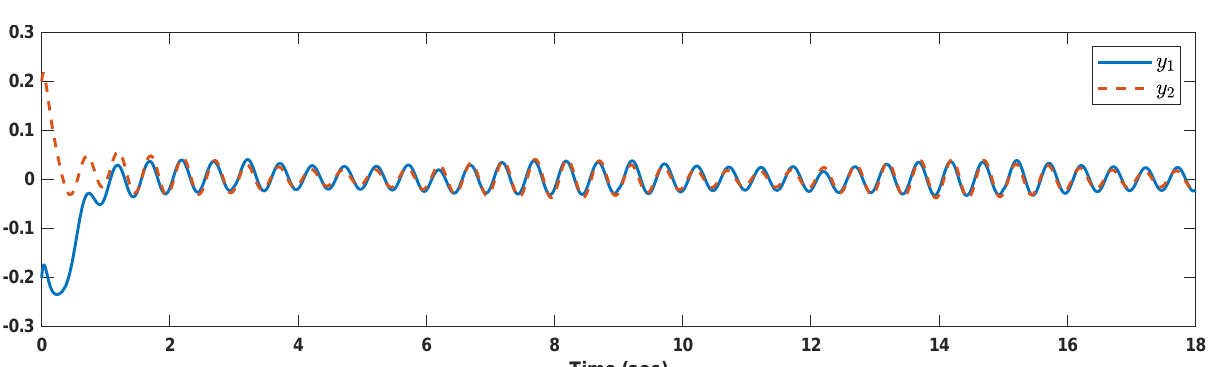
Figure 4. Example 1: Estimation error.